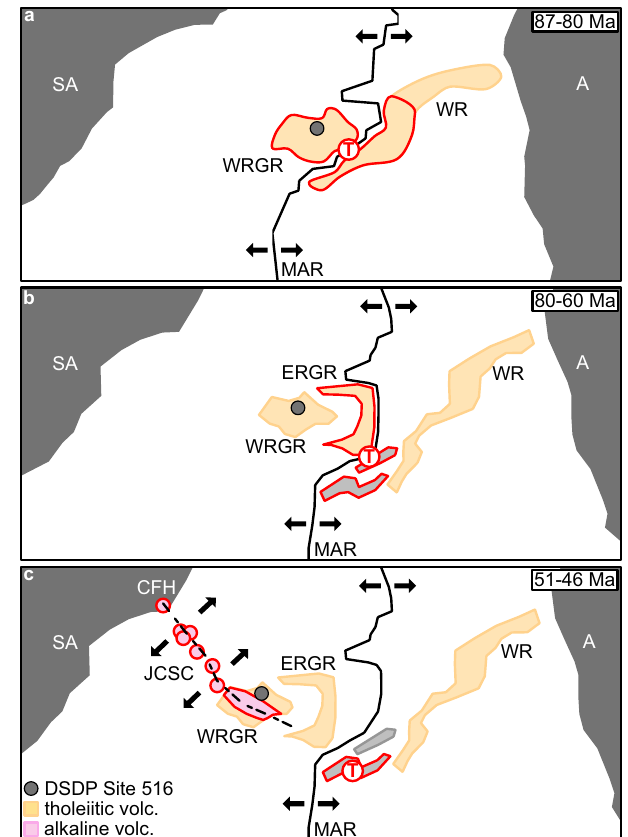
Fig. 7 Schematic sketch illustrating the geochemical and tectonic evolution of the Rio Grande Rise and Jean Charcot Seamount Chain (JCSC). a 87 – 80 Ma ago, the interaction of the Tristan-Gough mantle plume (red circled T) with the Mid-Atlantic Ridge (MAR) caused the formation of the western Rio Grande Rise (WRGR) and Walvis Ridge (WR). During this stage the tholeiitic Deep Sea Drilling Program (DSDP) Site 516 lavas were formed by high degrees of shallow melting of slightly enriched upper mantle material. b Between 80 and 60 Ma sea fl oor spreading separated the WRGR and WR and the tholeiitic eastern Rio Grande Rise (ERGR) lavas were formed due to plume – ridge interaction similar to those from DSDP Site 516. c Between 51 and 46 Ma, die formation of the Cruzeiro do Sul Rift (black dashed line) caused lithospheric rifting and possibly initiated the alkaline magmatism at the WRGR and Cabo Frio High as well as the formation of the JCSC. The Tristan-Gough mantle plume was situated beneath the African Plate during this time. The yellowish areas were formed by tholeiitic volcanism, the pink areas by alkaline volcanism. Areas outlined in red indicate active volcanism at this time. Black arrows indicate sea fl oor spreading at the MAR and lithospheric rifting during the formation of the Cruzeiro do Sul Rift. Abbreviations are as follows: SA South America, A